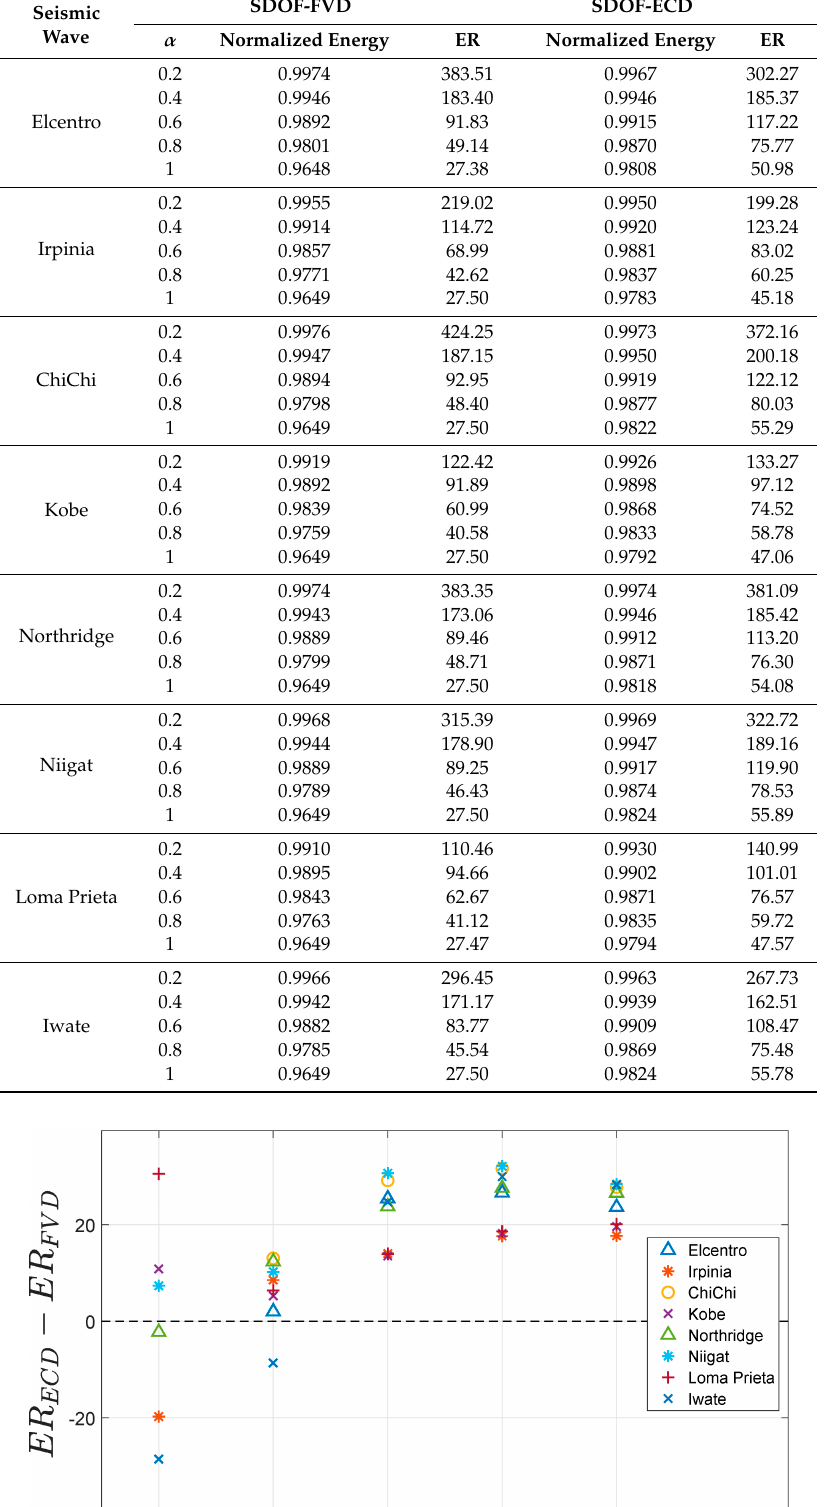
Table 3. Energy dissipation ratios (ERs) of SDOF-ECDs and SDOF-FVDs. Seismic Wave